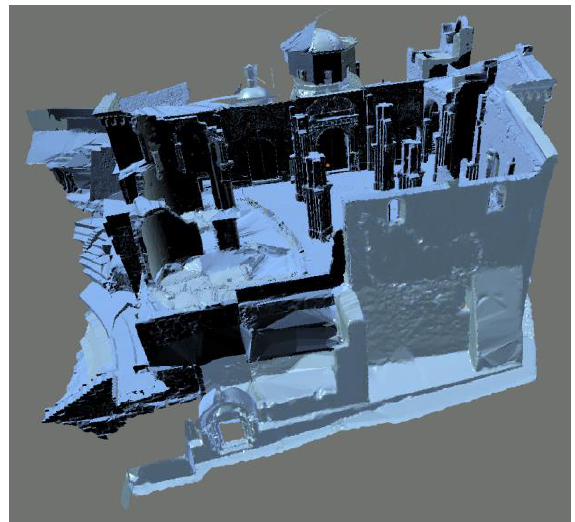
Figure 8. Image of the result of the mesh of points after the optimization and closing of the geometry of the building